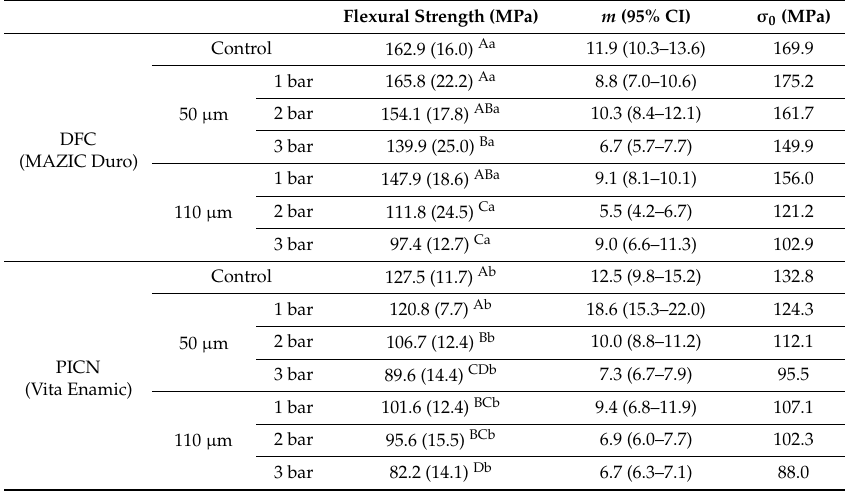
Table 1. Mean and standard deviation of flexural strength and Weibull parameters of DFC and PICN specimens according to air abrasion at different pressures (1, 2, 3 bar) with alumina of different particle sizes (50 µm, 110 µm).